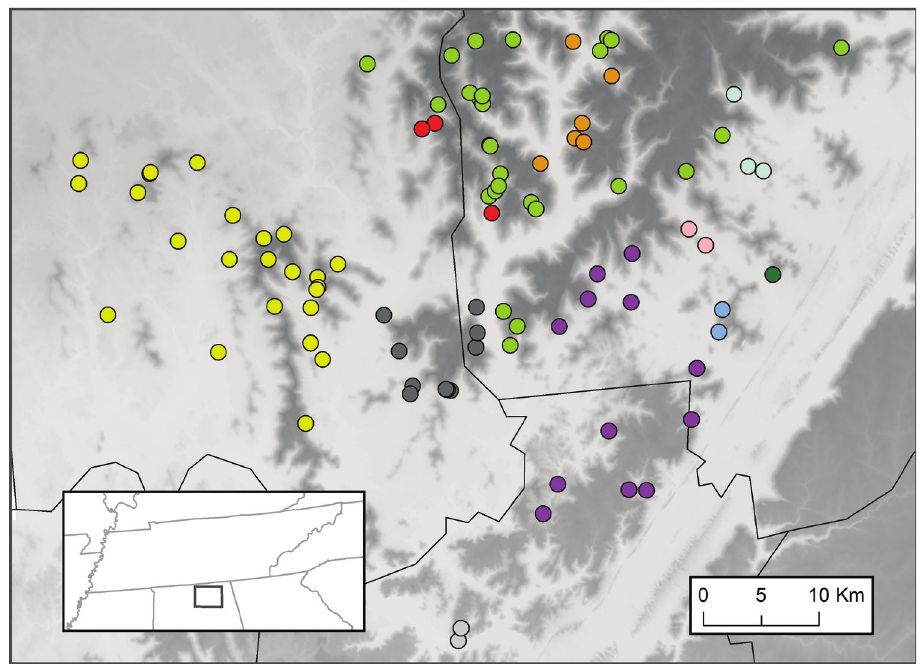
Figure 4. Distribution of Ptomaphagus species on the southern Cumberland Plateau, overlaid on a digital elevation model. Higher elevations (to 500 m) are indicated by darker shades, lower elevations (to 180 m) by lighter shades. Ptomaphagus species diverging early in the South Cumberlands lineage are limited to isolated ridges and mountains on the fringes of the plateau. These species are P. loedingi (yellow), P. longi- cornis (dark gray), P. julius (blue), P. solanum (dark green) and P. hazelae (light blue). The colors used here correspond to those in Figure